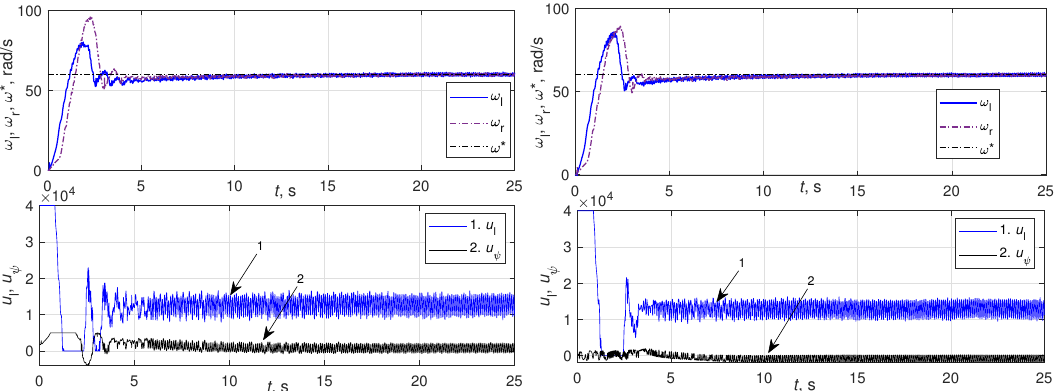
Figure 5. Experiment. IMR output error ε ψ ( t ) = ψ M ( t ) − ψ ( t ) time history for ψ ∗ = 0. Linear error ( left plot ), sine-modification ( right plot ).